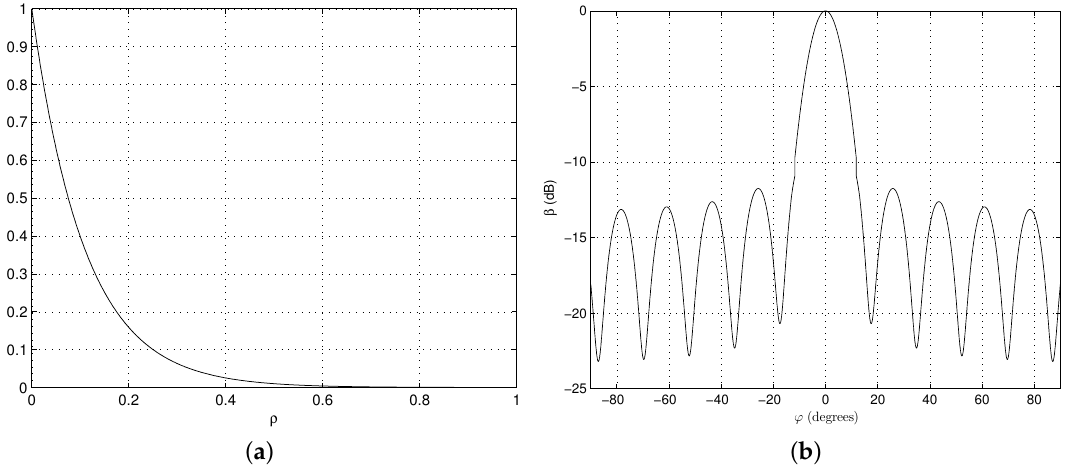
Figure 3. The relationships between the substitution and the practical parameter. ( a ) α versus beam isolation parameter ρ ; ( b ) Normalized radiation pattern of β versus elevation angle ϕ